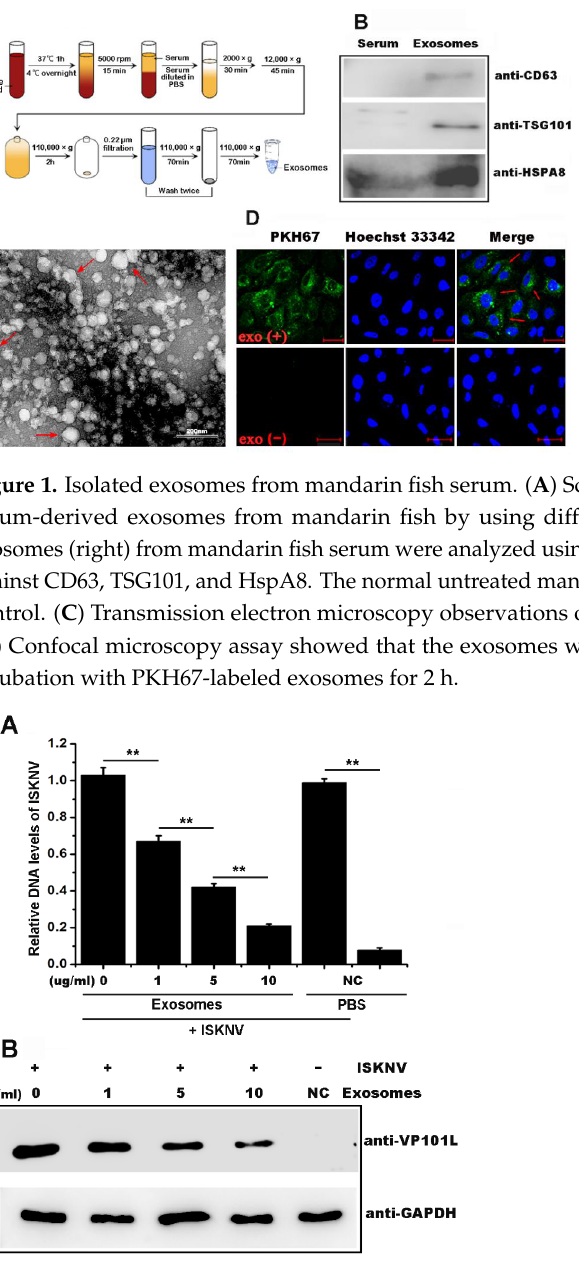
Figure 2. Mandarin fish serum-derived exosomes inhibit ISKNV infection. ( A ) Cells were incubated with 0, 1, 5, and 10 µ g/mL exosomes after infection with ISKNV at a MOI of 1 (lanes 1–4); incubation with PBS as positive control (lane 5) and uninfected cells (lane 6) as negative control (NC); the DNA copies of isknv-mcp were quantified via absolute quantitative real-time PCR in MFF-1 cells at 48 h post infection. The copies of β -actin DNA were also measured by absolute quantitative real-time PCR analysis used as an endogenous reference to normalize the cell number variations in each sam- ple. The y-axis represents the DNA copies of isknv-mcp/ the DNA copies of β -actin . Vertical bars rep- resent statistical significance as indicated by asterisks, with ** referring to p < 0.01. ( B ) Western blot analysis of the ISKNV-VP101L protein after 48 h of infection.